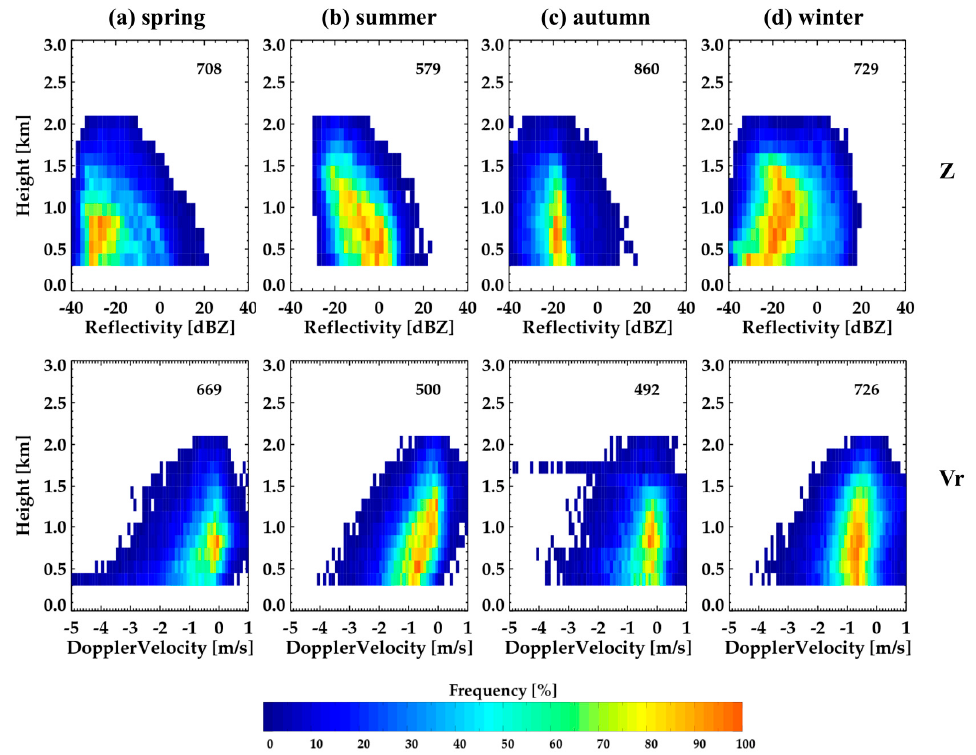
Figure 19. The same as in Figure 14, except for RainSH. ( a ) Spring, ( b ) summer, ( c ) autumn, and ( d ) winter.